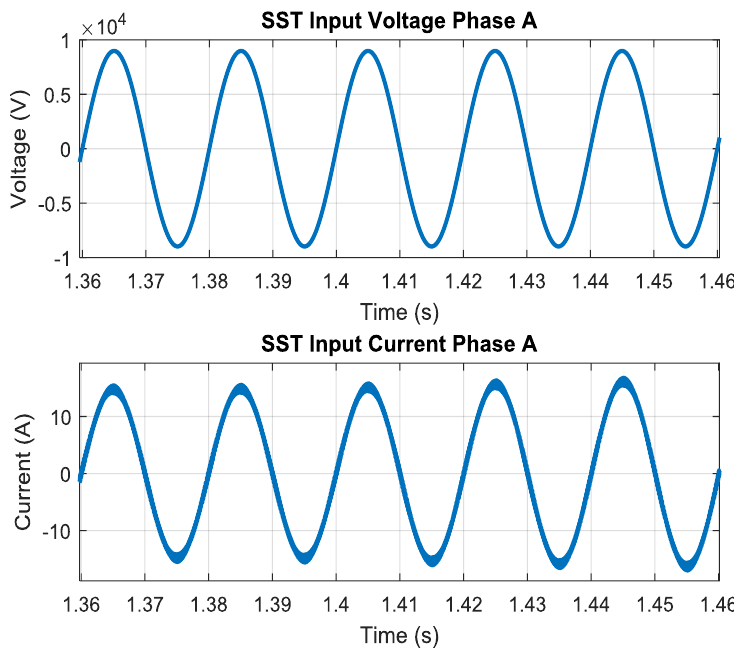
Figure 30. Result displaying that phase A voltage and current are in phase.